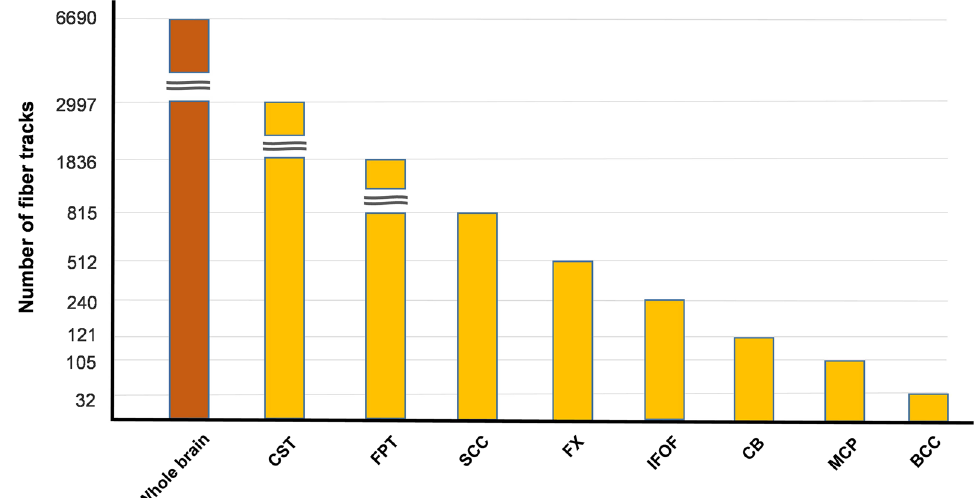
Fig. 6 Increased number of neuronal fiber tracks with high‑dielectric pad compared to without. CST Corticospinal tract; FPT Frontopontine tract; SCC Splenium of corpus callosum; FX Fornix; IFOF Inferior fronto‑occipital fasciculus; CB Cerebellum; MCP Middle cerebellar peduncle; BCC Body of corpus